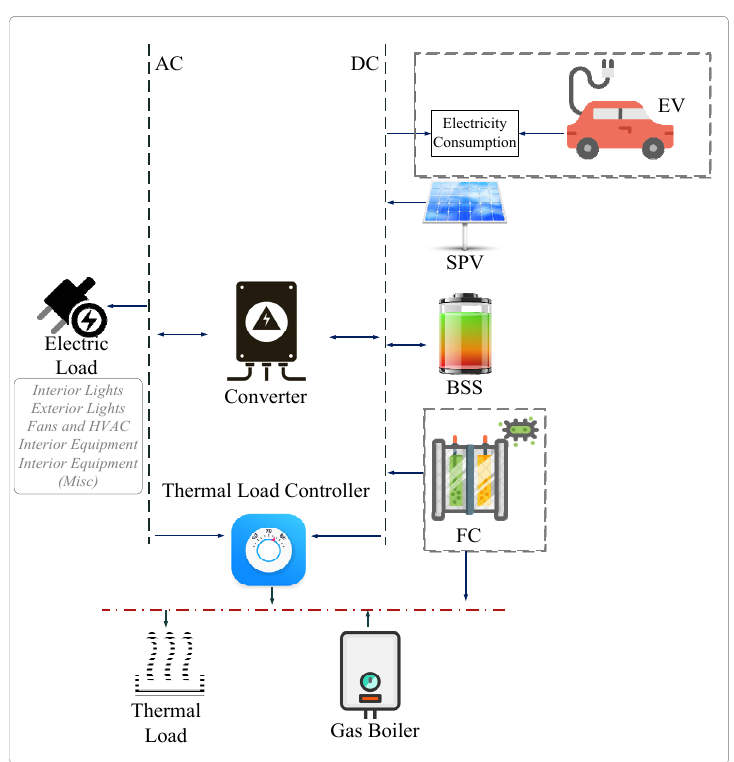
Figure 2. Different categories, according to the previous research works, in the field of the optimal sizing and techno-economic assessment of hybrid energy systems.